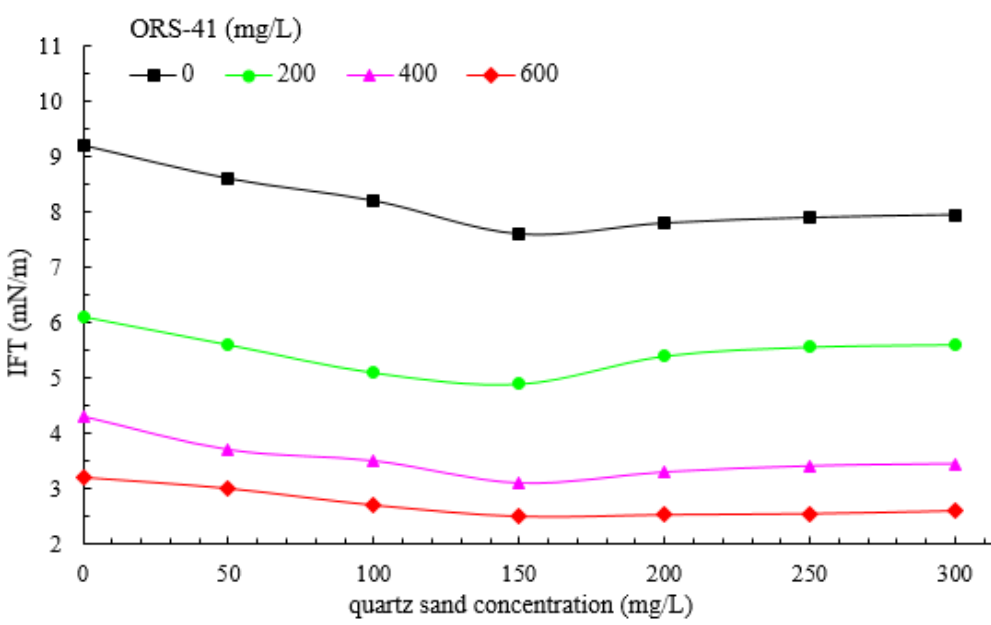
Figure 10. The synergetic effect of quartz sand particles and surfactant on interfacial tension (polymer concentration 500 mg/L, alkali concentration 600 mg/L).